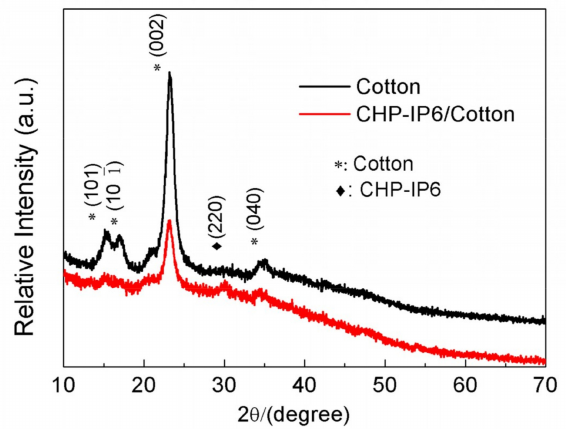
Figure 3. X-ray diffractometry patterns of cotton fabric and CHP-IP6 coated cotton fabric.